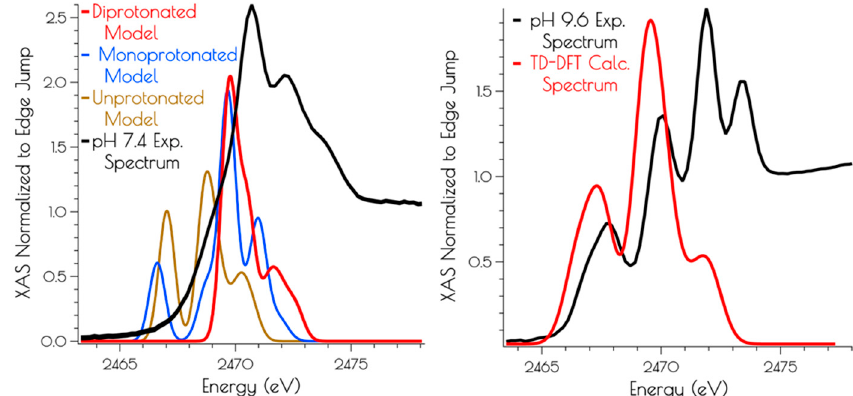
Figure 7. Left: Experimental (black spectrum) pH 7.4 and TD-DFT calculated S K-edge X-ray absorption spectra models of {Ni 2II (SOD mds )} (unprotonated model: gold spectrum; monoprotonated model: blue spectrum; doubly-protonated model: red spectrum). Right: Experimental (black spectrum) pH 9.6 and calculated spectrum (disulfide bridged model: red spectrum) of {Ni 2II (SOD mds )}.